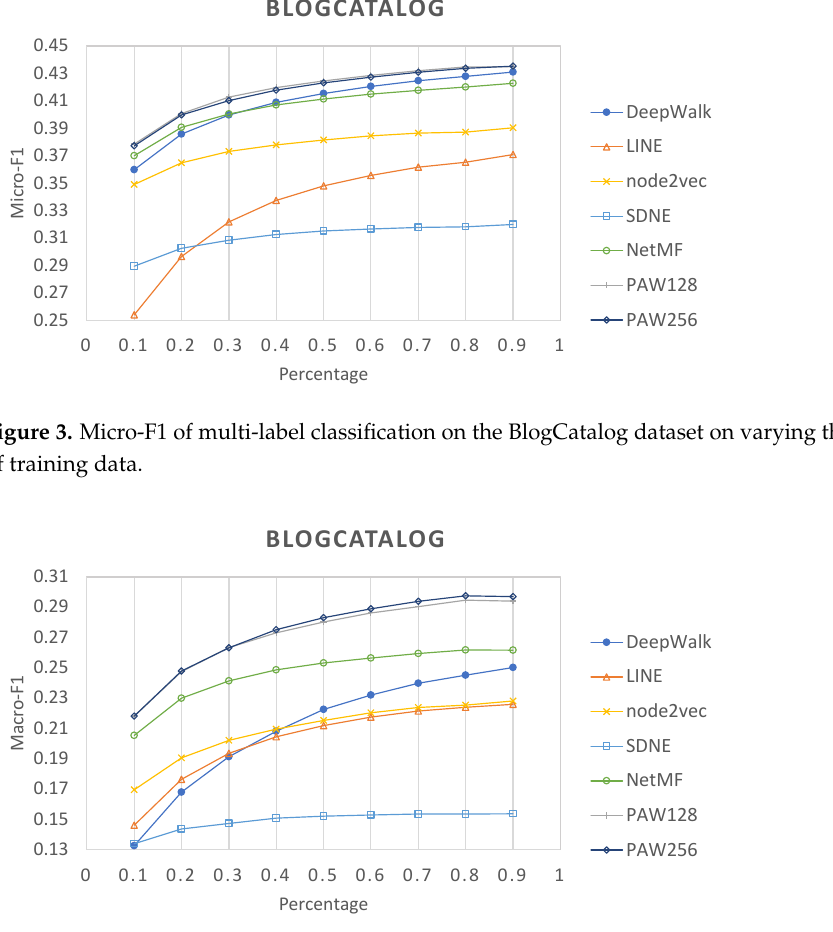
Figure 4. Macro-F1 of multi-label classification on the BlogCatalog dataset on varying the proportion of training